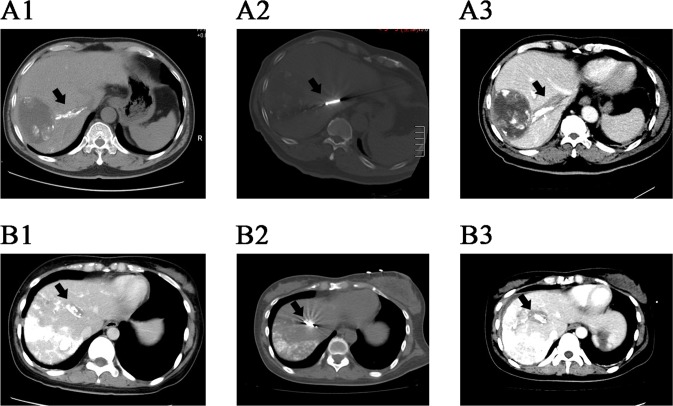
CT scanning of two patients with HVTT.(A1) CT scan of patient A after transcatheter arterial embolization showed tumor thrombus in the right hepatic vein. Lipiodol deposition in the thrombus feeding artery labeled the thrombus on CT imaging. (A2) Intra-operative CT scan of the ablation of thrombus. (A3) Instant post-operative contrast-enhanced CT of patient A showed complete necrosis of the thrombus: the thrombus was completely surrounded by the low density ablation zone. (B1) CT scan of patient B showed tumor thrombus and lipiodol deposition in the middle hepatic vein. (B2) Intra-operative CT scan of the ablation of thrombus. (B3) Instant post-operative contrast-enhanced CT of patient B showed that the thrombus was completely surrounded by the low density ablation zone. CT, computed tomography; HVTT, hepatic vein tumor thrombus.